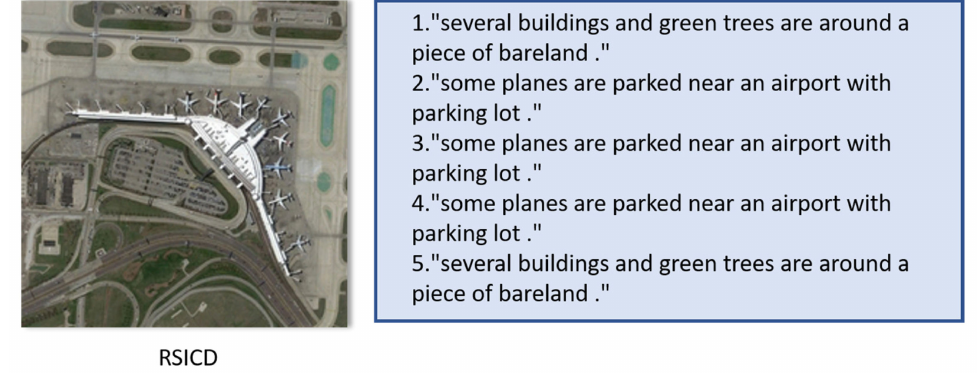
Figure 9. A randomly selected remote sensing image from the RSICD dataset and the